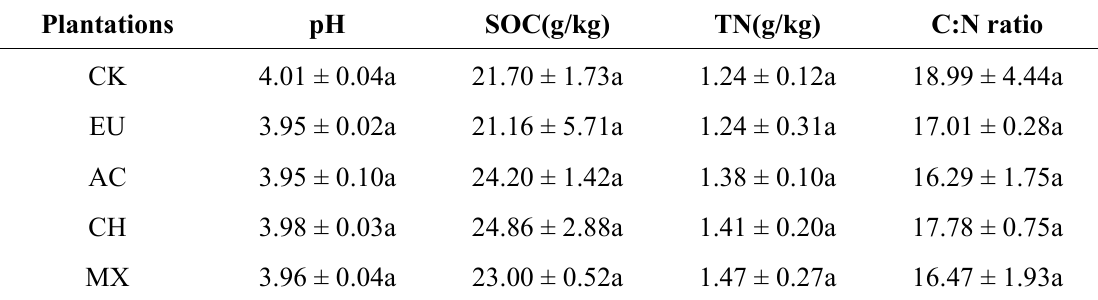
Figure 3. Proportion of trees, shrubs and herbs in total living plant carbon storage among plantations. Values are the means + SE, n = 3. Different lowercase letters indicate significant differences in the percentage of trees and herbs’ total carbon storage among plantations for at the p = 0.05 level. See Figure 1 for the abbreviations. Table 3. Comparison of surface soil physical and chemical properties (0–10 cm) among plantation types at 6 years of